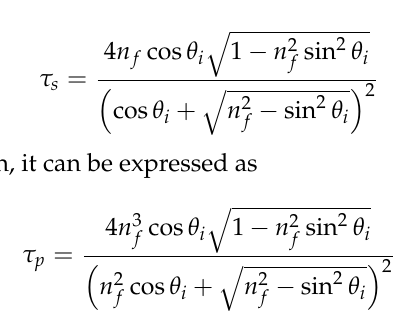
Figure 6. Schematics of optical loss on the end considering polarization.